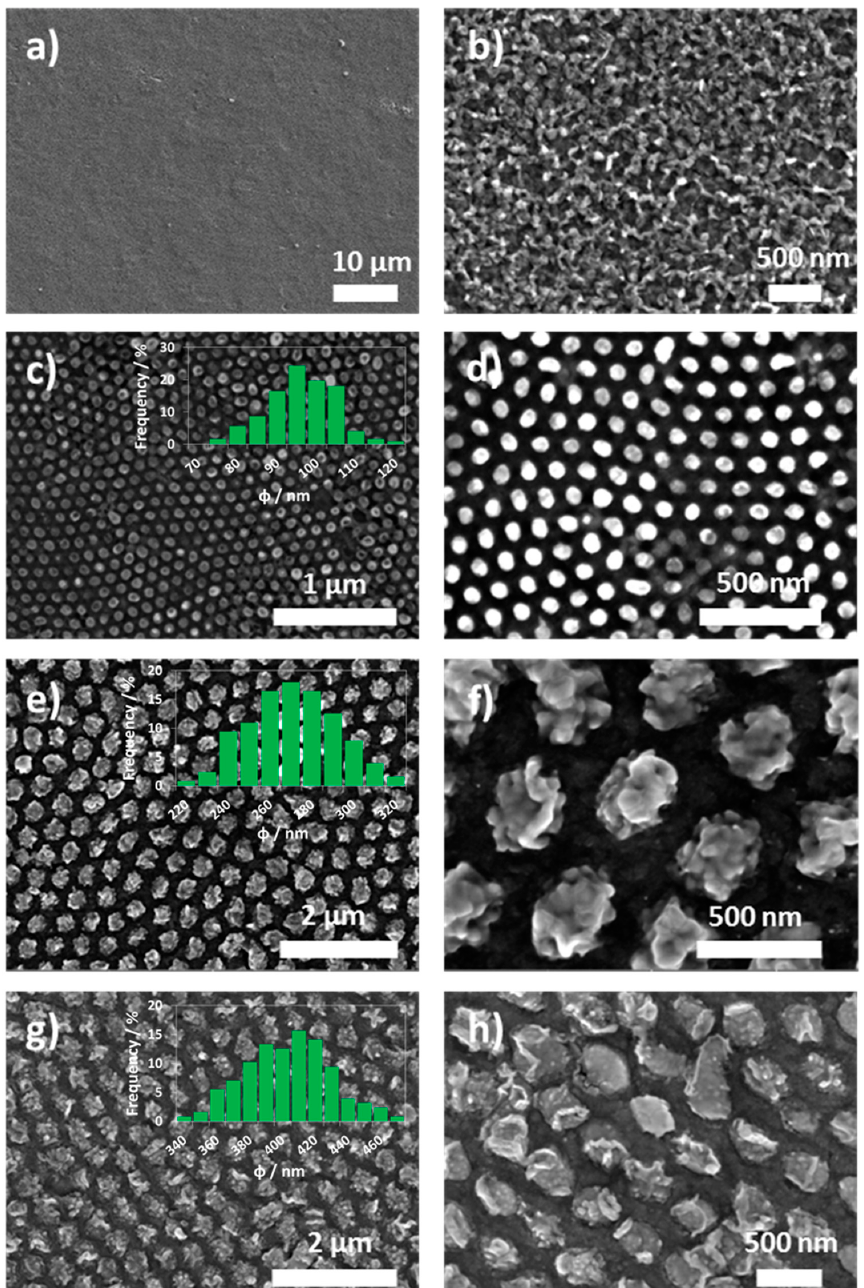
Figure 4. SEM top images of an iron oxide compact layer ( a , b ) synthesized by e-beam evaporation directly on a Ti foil, and iron oxide nanopillars synthesized by e-beam evaporation using AAO templates with different diameters: φ 90 nm ( c , d ), φ 260 nm ( e , f ) and φ 400 nm ( g , h ) on Ti foils.